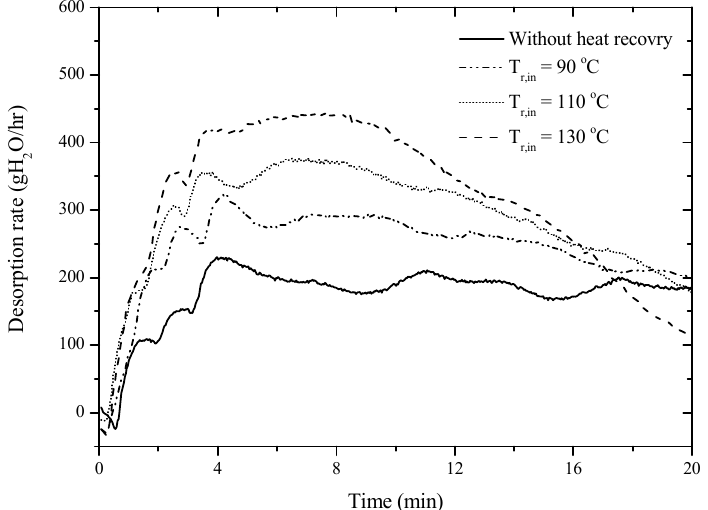
Figure 8. The variation of the desorption rate of the heat pipe-based desiccant device with time at various heat recovery temperatures at an inlet temperature of 60 ◦